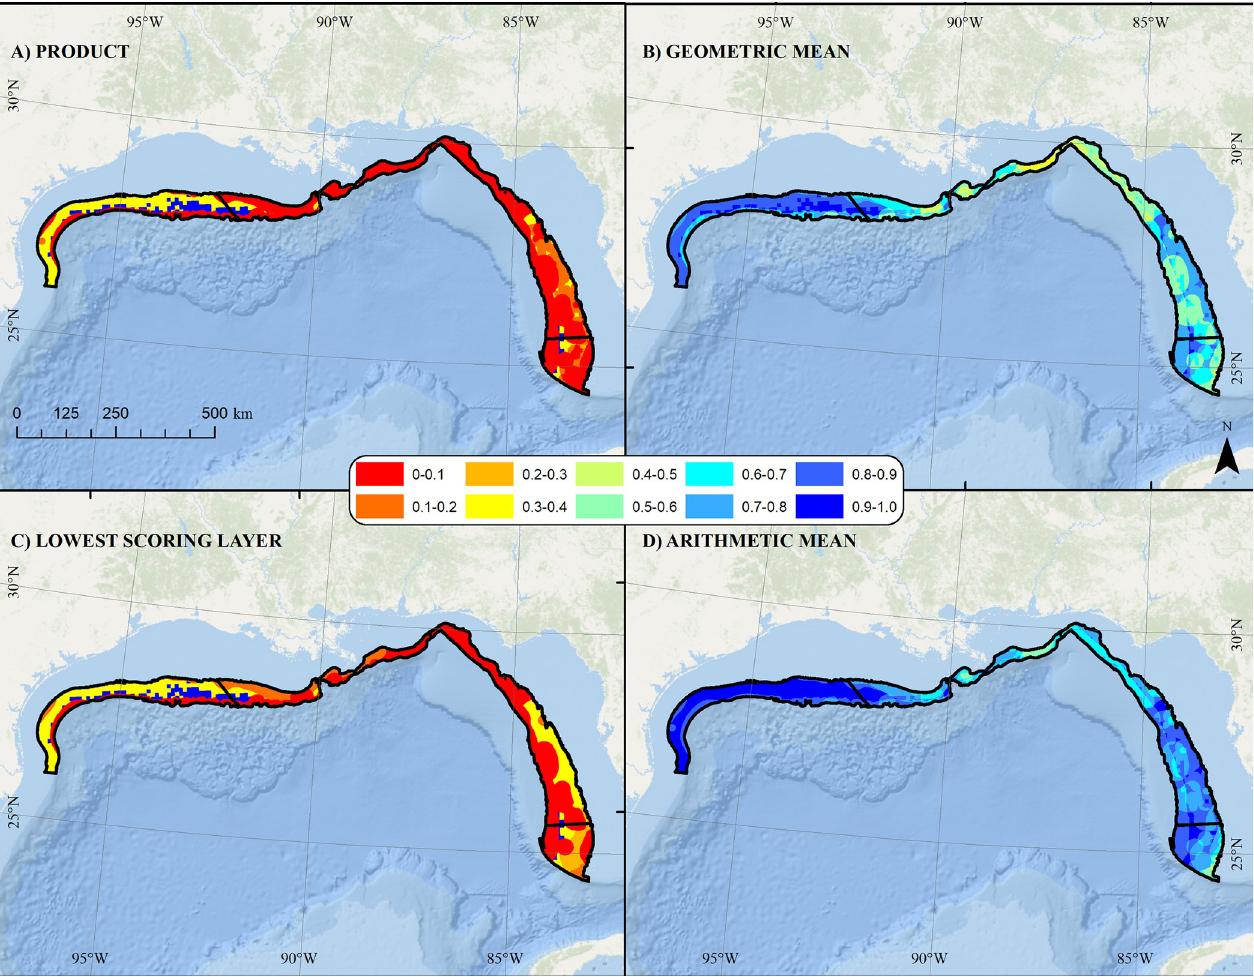
Fig 8. Combined scored protected species data layer. Combined Gulf of Mexico protected species data layer showing A) Product, B) Geometric Mean, C) Lowest Scoring, and D) Arithmetic Mean combined scores across proposed aquaculture study areas (black). Warmer colors denote areas of relatively higher concern with regards to species status, population size, and trajectory. Map developed in ESRI ArcGIS 10.8.1. Basemap from Esri Ocean Basemap and its partners, reprinted from ESRI under a CC BY license, with permission from ESRI, original copyright 2022. Projection: UTM NAD83 Zone